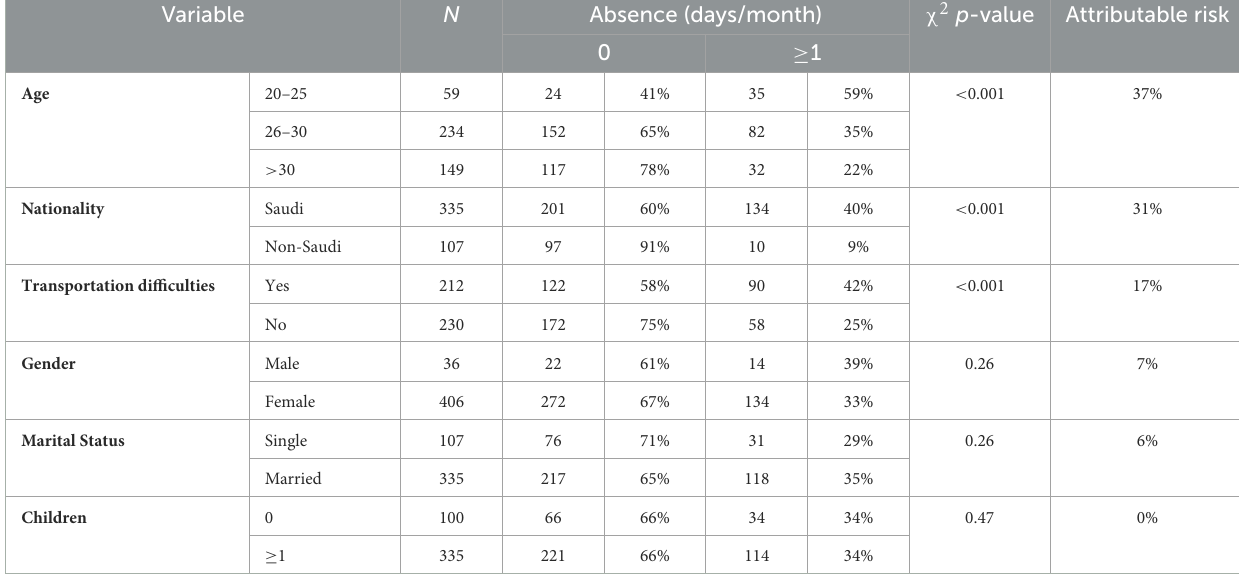
TABLE 1 Personal factors associated with